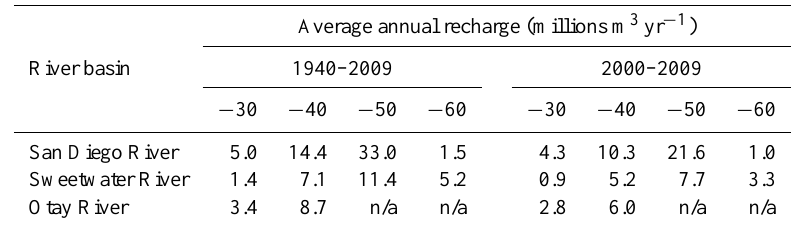
Table 5. Average annual recharge calculated using the Basin Characterization Model for three river basins in the San Diego region for areas defined on the basis of measurements of δ deuterium, in per mil.